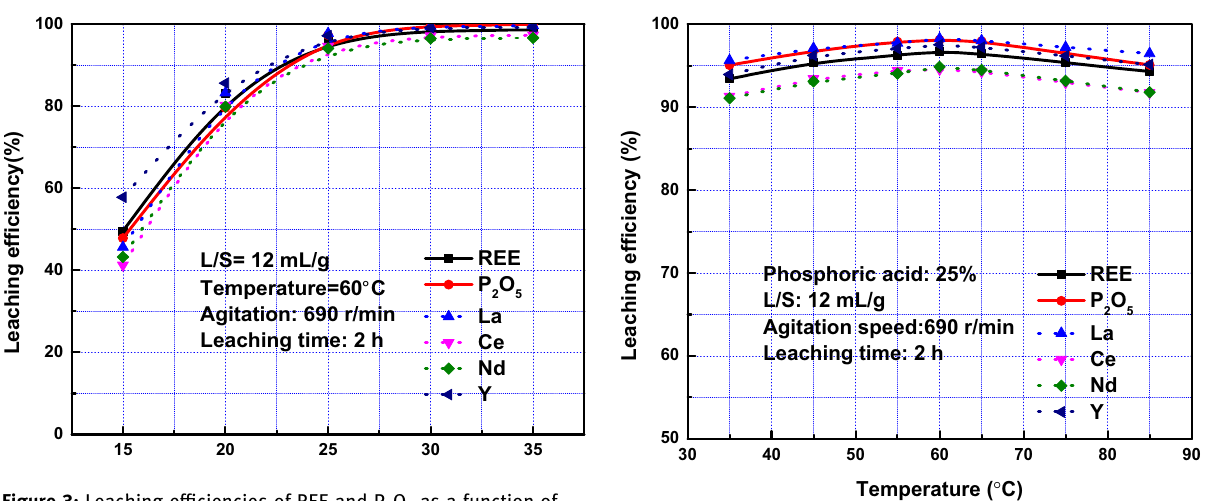
Figure 5: Leaching e ffi ciencies as a function of leaching